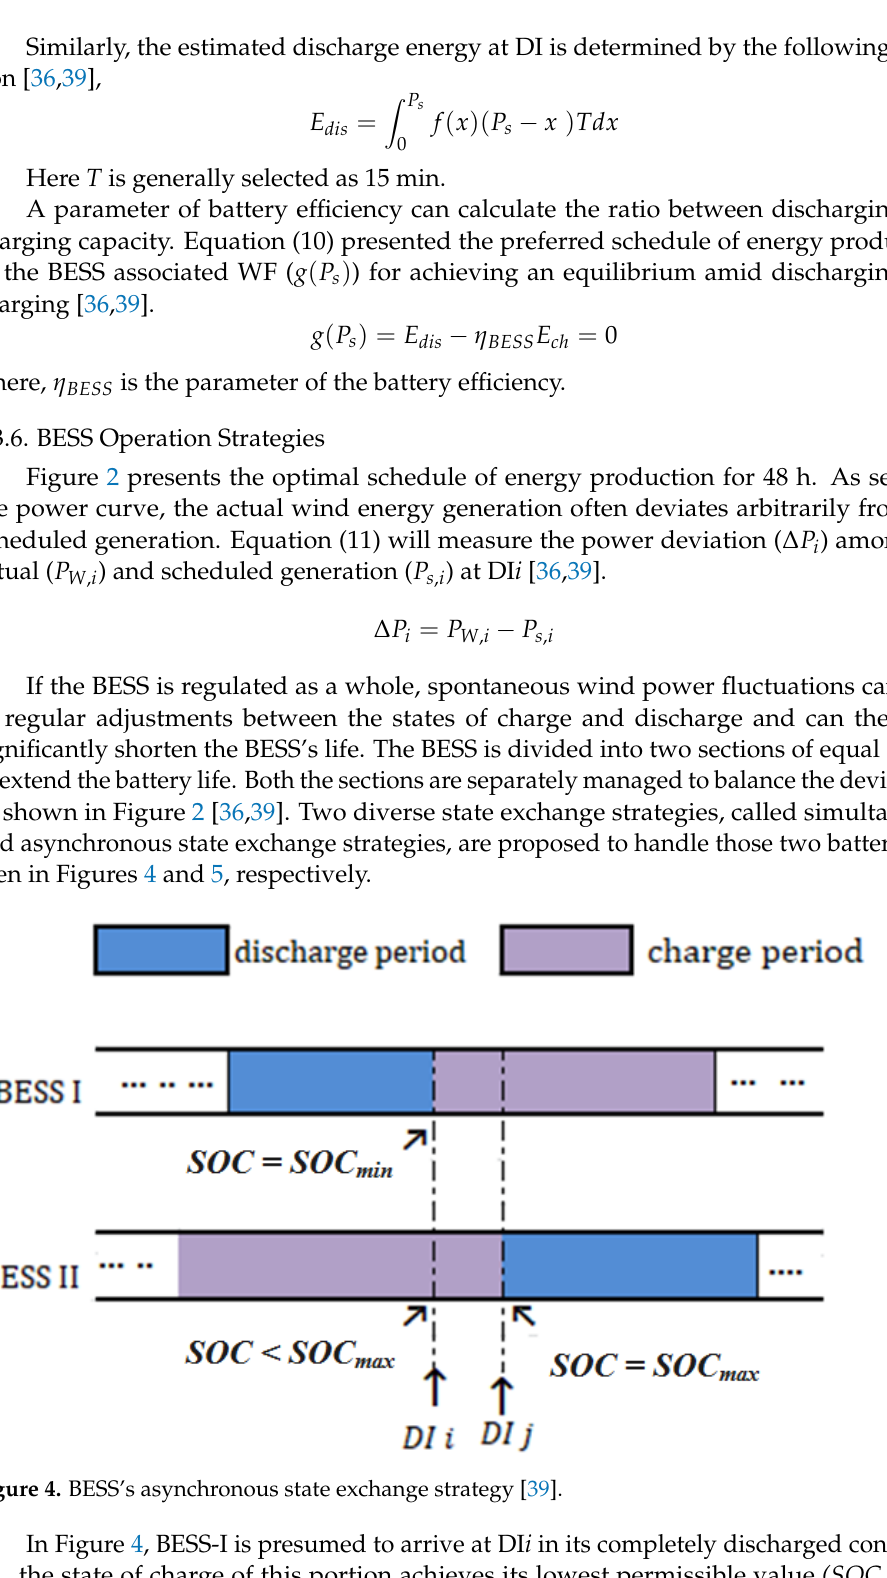
Figure 5. BESS’s simultaneous state exchange strategy [39].